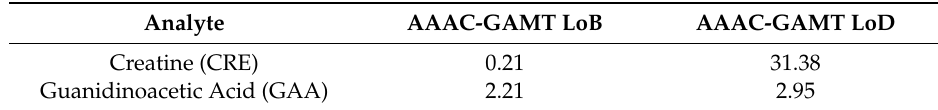
Table 4. AAAC-GAMT non-derivatized assay limit of blank (LoB) and limit of detection (LoD) ( n = 120). Units: µ M